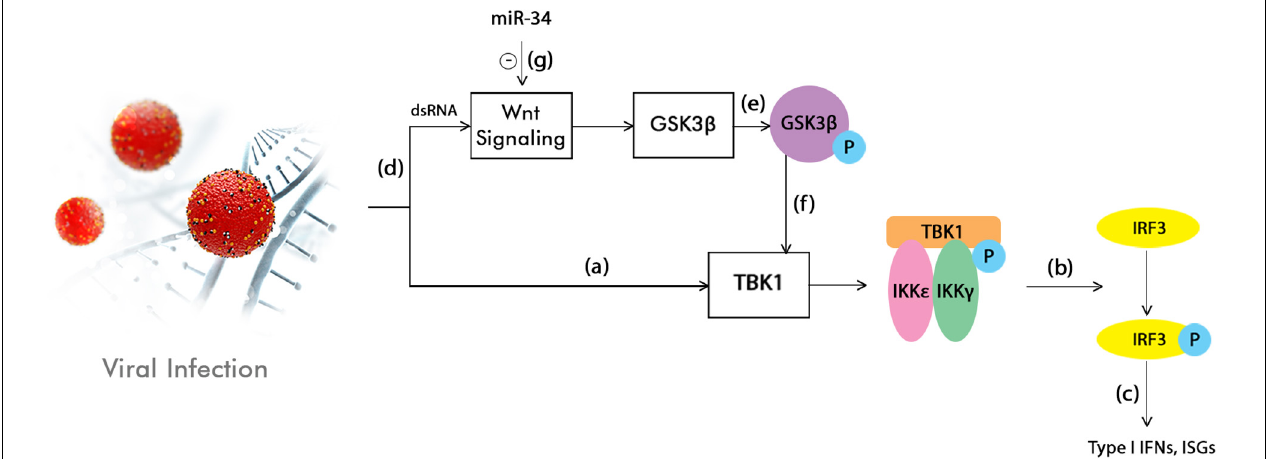
FIGURE 1 | Interferon (IFN) signaling enhancement by the inhibition of the Wnt pathway through miR-34. TANK-binding kinase 1 (TBK1) phosphorylation is firstly induced by the activation of the innate immunity in response to a viral infection (a) . This is followed by the phosphorylation or homodimerization of the interferon regulatory factor 3 (IRF3) (b) , which is subsequently translocated into the nucleus. Here, it stimulates the production of type I IFNs and interferon stimulated genes (ISGs) (c) . At the same time, the viral infection or dsRNA treatments also activate the Wnt signaling pathway (d) , which in turn leads to the inhibition of the Glycogen synthase kinase 3 beta (GS3K β ) phosphorylation (e) . This event suppresses the IFN pathway by interacting with TBK1 (f) . This model shows that the Wnt signaling pathway has the ability to modulate the innate inflammatory response. By acting as an inhibitor of the Wnt pathway, miR-34 could enhance type I IFN signaling, therefore leading to a cellular antiviral status ( g ; Smith et al.,